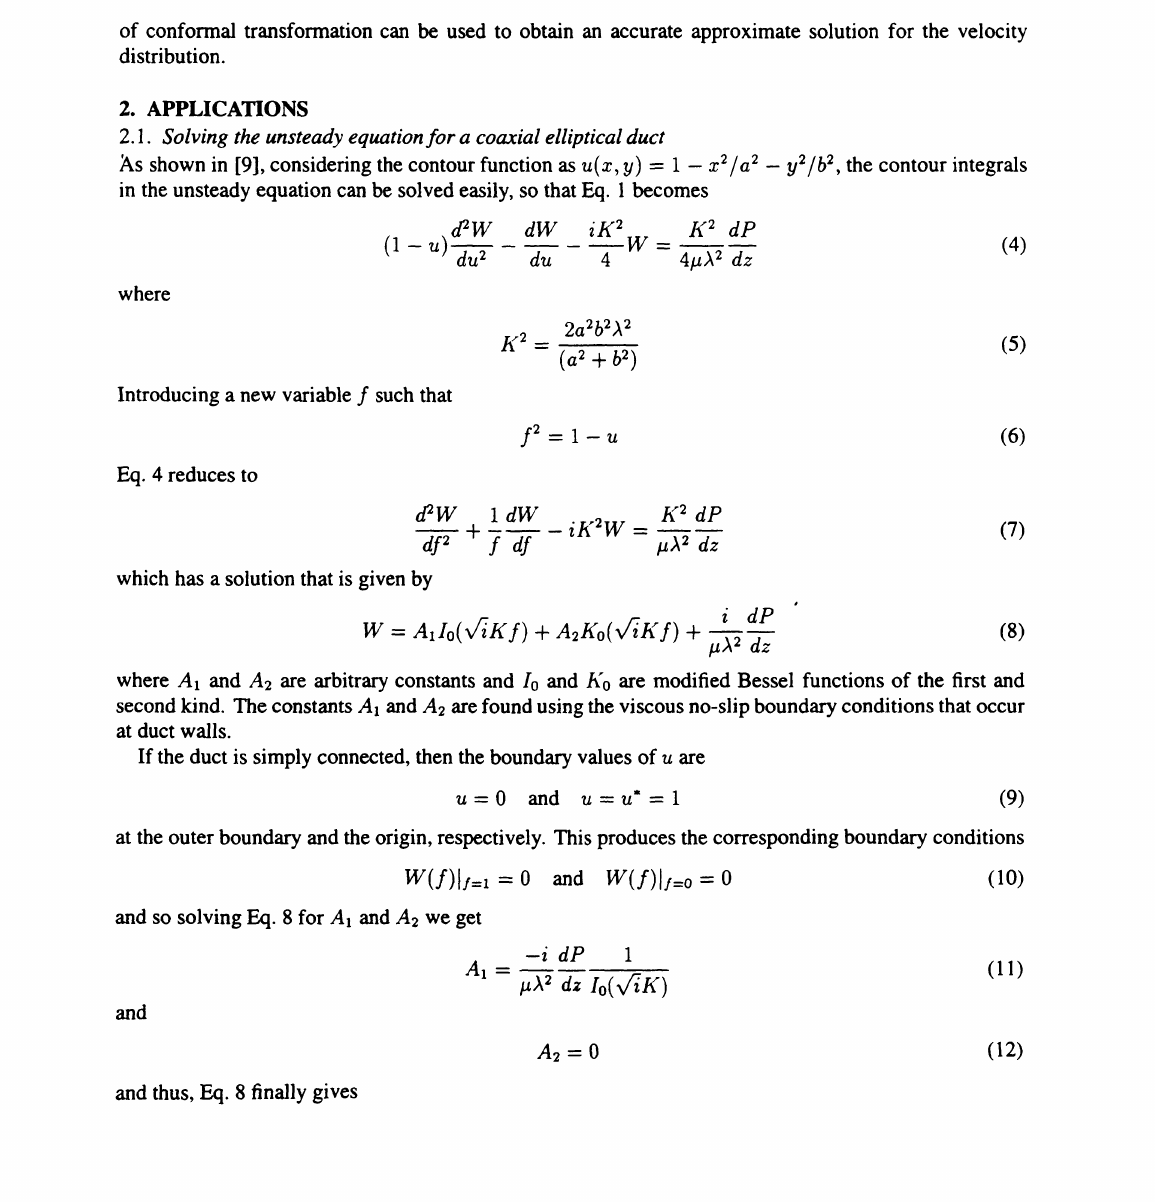
FIGURE I. Isovelocity contour